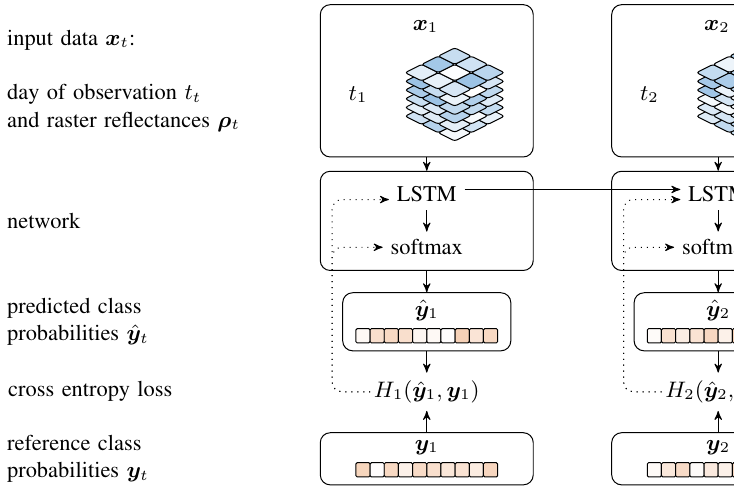
Figure 3. Unrolled flow of data for classification and training. Class probabilities ˆ y t are calculated by multiple stacked LSTM layers and one softmax layer. LSTM layers have additional access to cell state vectors c t 1 and h t 1 originating from previous observations, − − indicated by an arrow between processing columns, which benefits extraction of temporal features. At each training step, the cross entropy loss H t (ˆ y t , y t ) between predicted and reference class probabilites is calculated. To minimize the loss function, gradients (dotted) are calculated by Adam optimizer and adjust the network weights in involved in LSTM and softmax